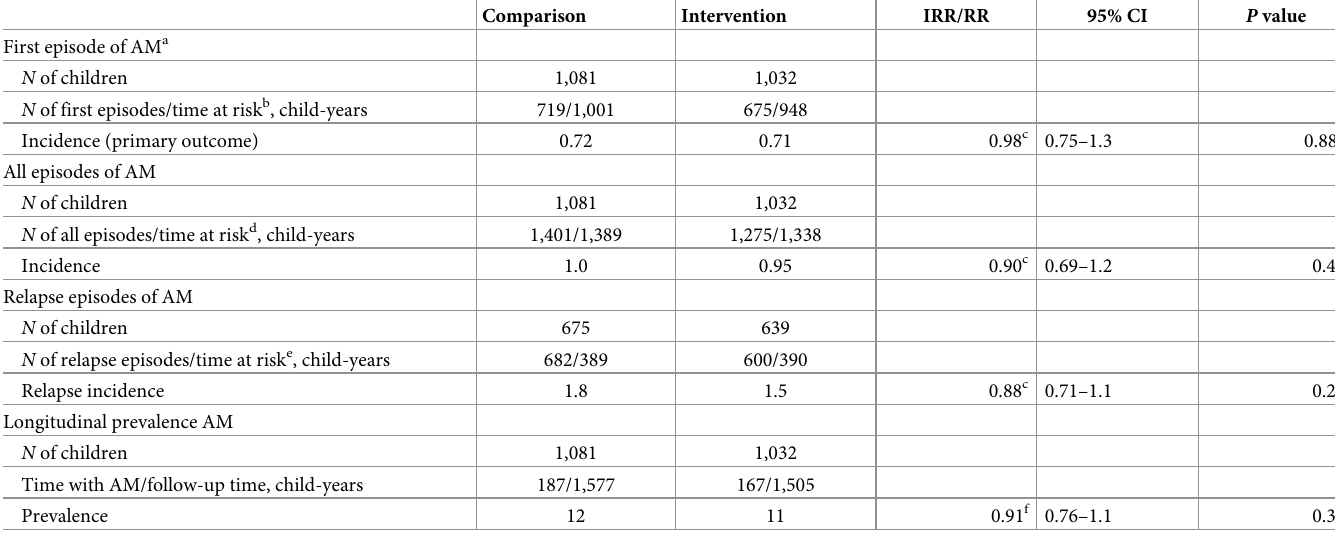
Table 7. Effect of the intervention on the incidence, relapse, and longitudinal prevalence of AM assessed by longitudinal